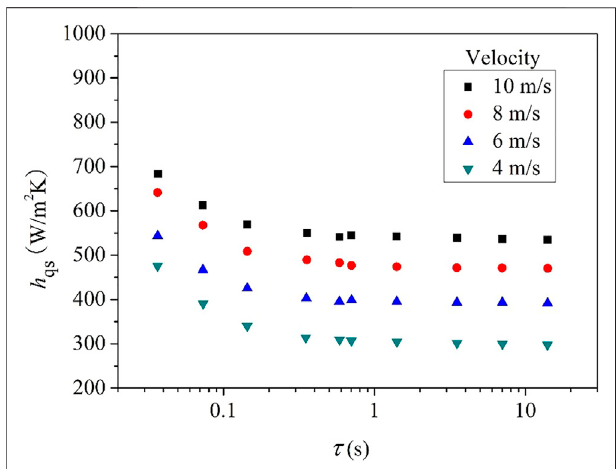
FIGURE 7 | Quasi-steady heat transfer coef fi cient at various heat generation periods and